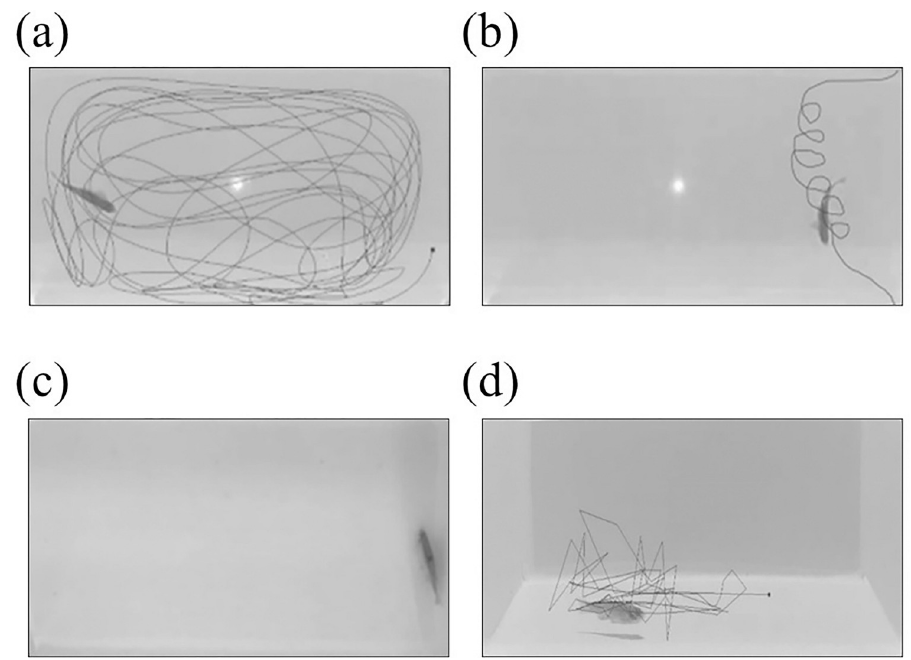
Fig 8. Graphical representation of the swimming paths (in black) during the three-minute behaviour test. Each figure represents distinct swimming phenotype, (A) normal continuous swimming (top view), (B) looping (top view), (C) freezing (top view), and (D) erratic movement (side view). The paths were generated by the EthoVision XT tracking software.